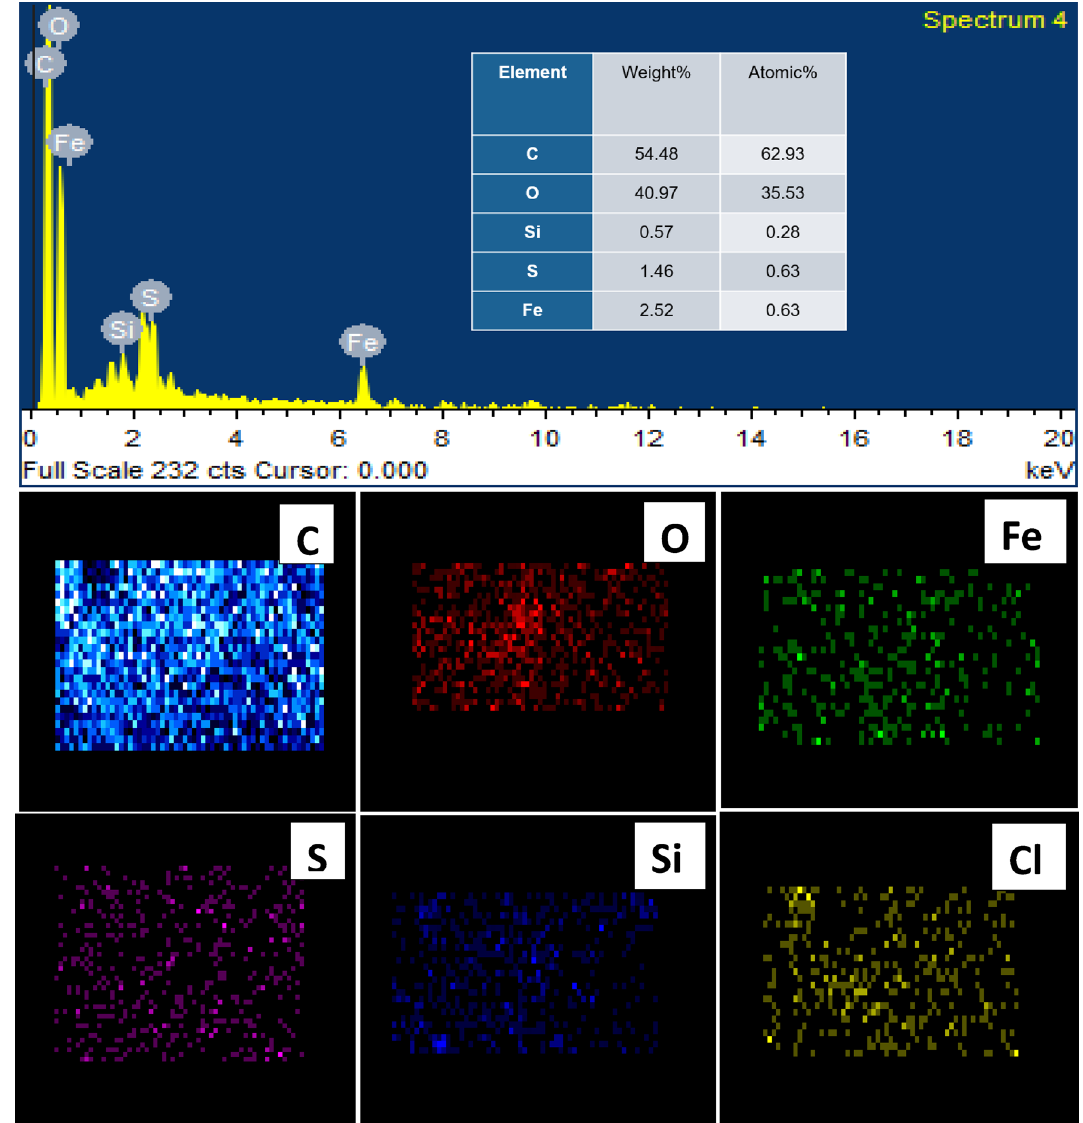
Figure 6. EDX spectra of composite of GO/Iron-oxide nanocomposites. Elemental mapping of reflects the presence of different constituents, C (Carbon), O (oxygen), Fe (Iron) S (Sulfur) Si (Silicon) and Cl (Chlorine) in nanocomposite